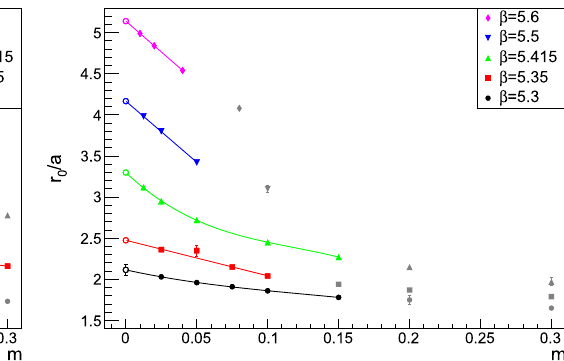
of our fit procedure. In most cases the error bar is smaller than the symbol. The orders of the polynomials used in the fits are in Table 4 Table 4 Results of the chiral extrapolation for the plaquette and the scale. The order of the polynomials used in the fits is indicated β (cid:3) 1 − P (cid:4) MC Pol. ord.